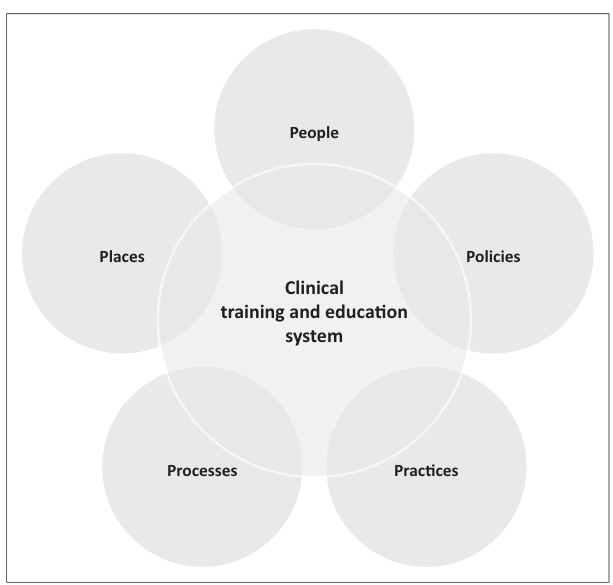
FIGURE 2: The 5 Ps of influencing factors towards decolonial speech-language and hearing professions in South Africa.